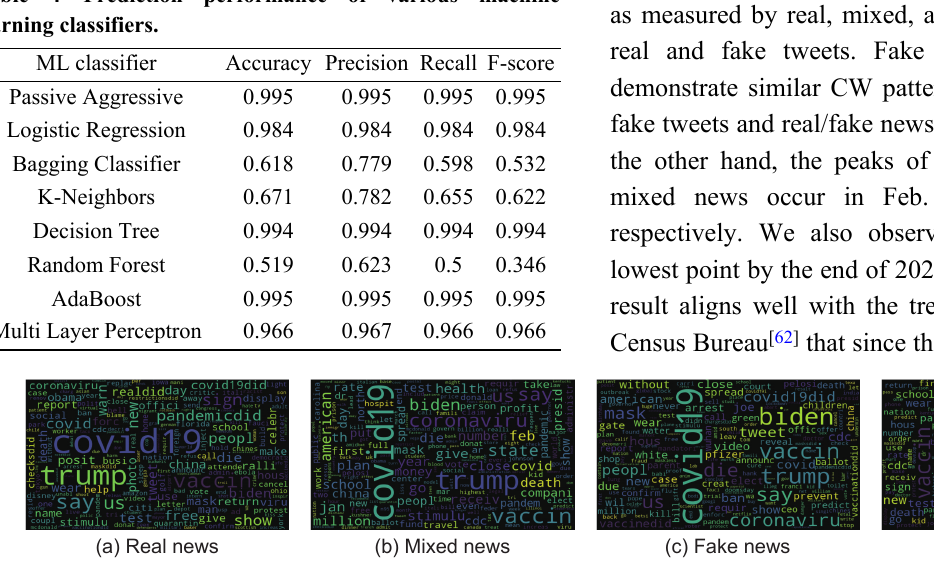
Fig. 4 Word cloud for real, mixed, fake, and all news for Jan. 2020–Jun.